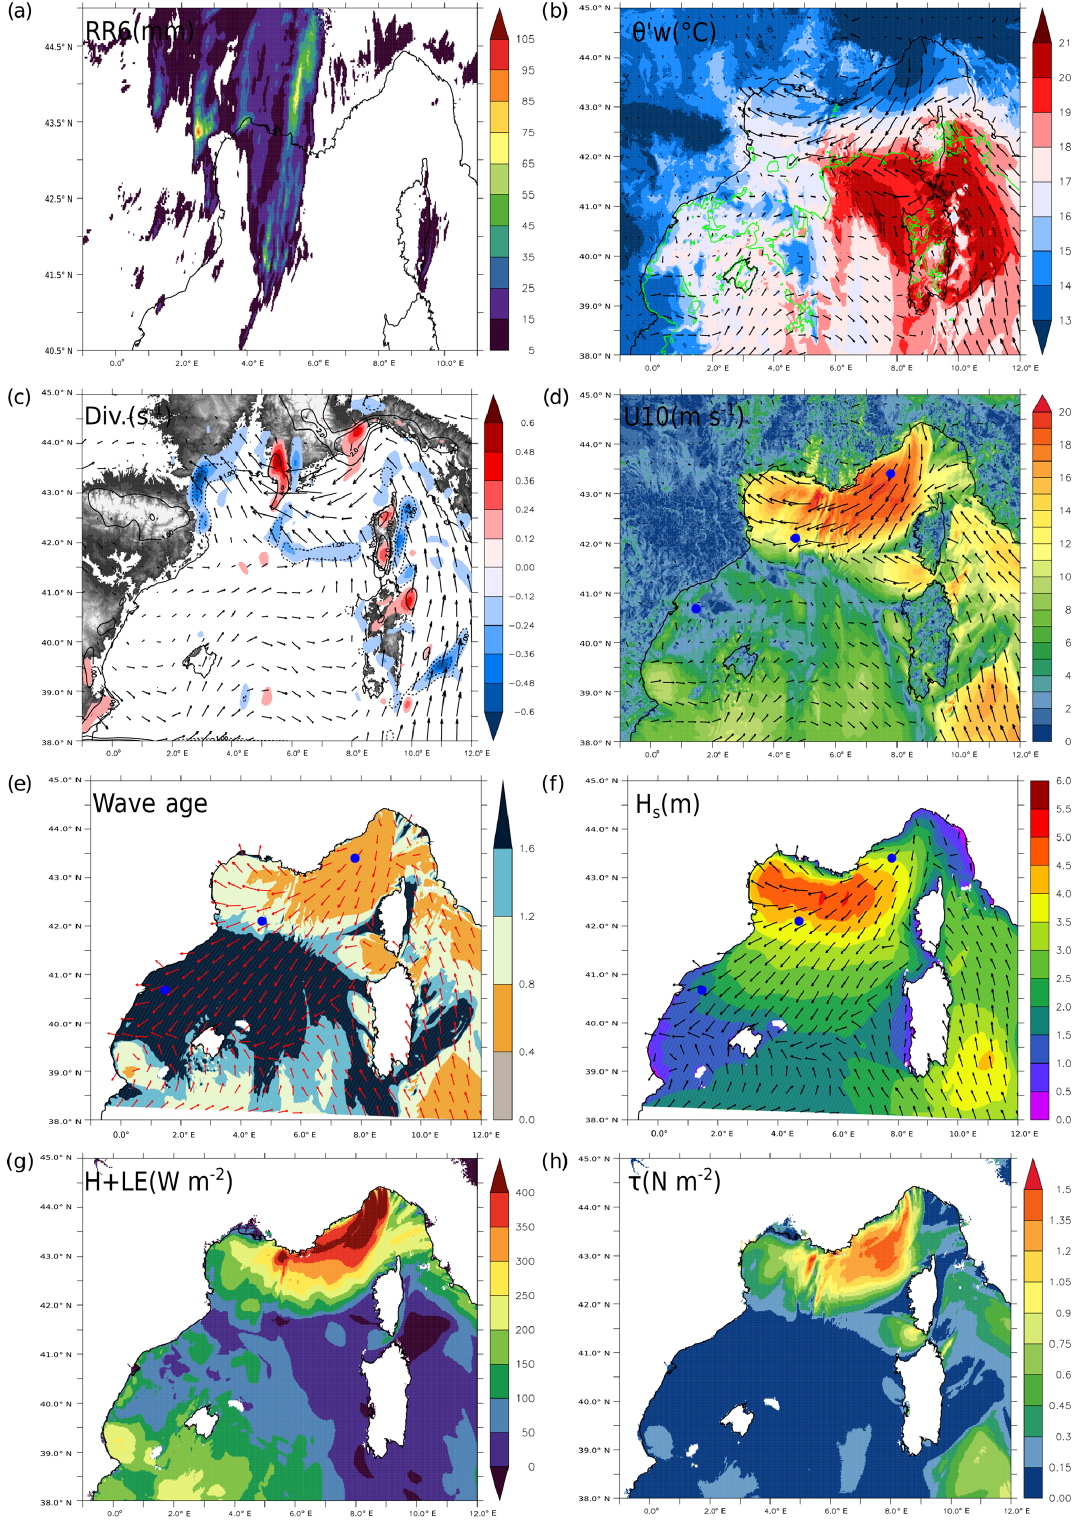
Figure 6. Same as for Fig. 5 but at 00:00UTC on 14